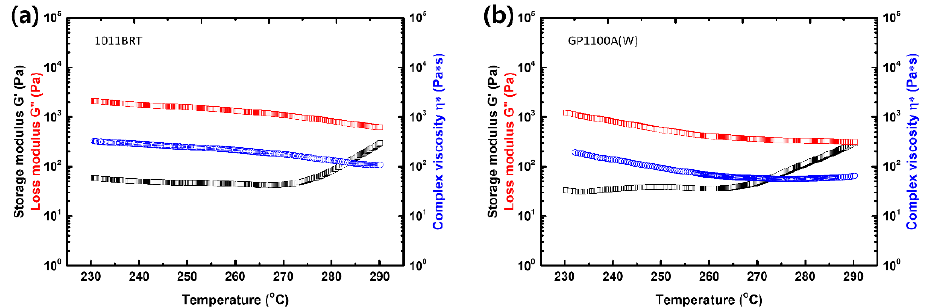
Figure 4. Results of rotational rheometer tests for PA6 resin: ( a ) 1011 BRT and ( b ) GP 1100A (W).